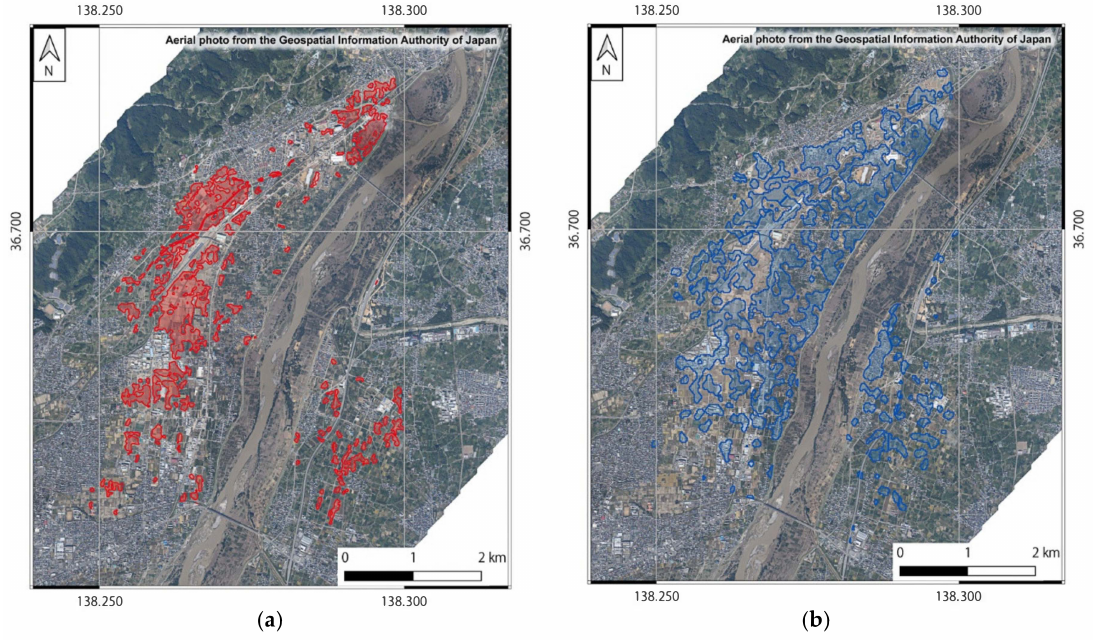
Figure 5. Comparison of the intensity images: ( a ) pre-event image from path 19 on 29 September 2015 and ( b ) post-event image from path 20 on 13 October 2019.